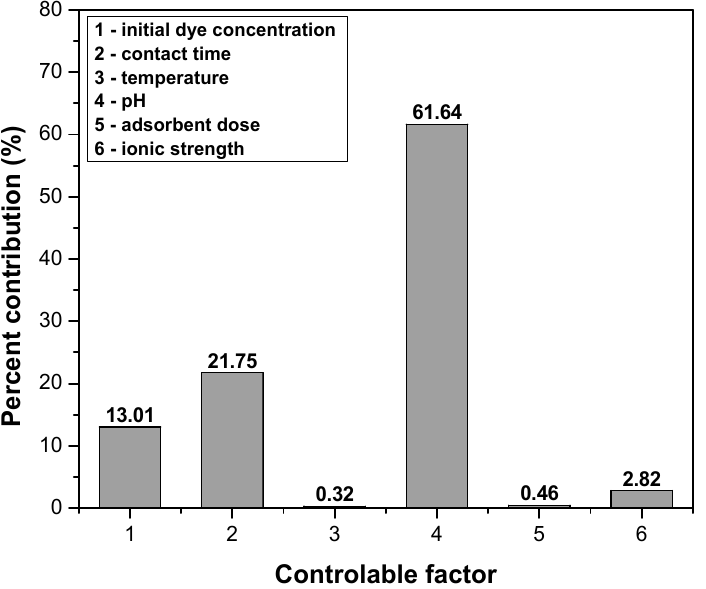
Figure 10. The contribution percentage of controllable factor influence on crystal violet removal efficiency based on ANOVA analysis.